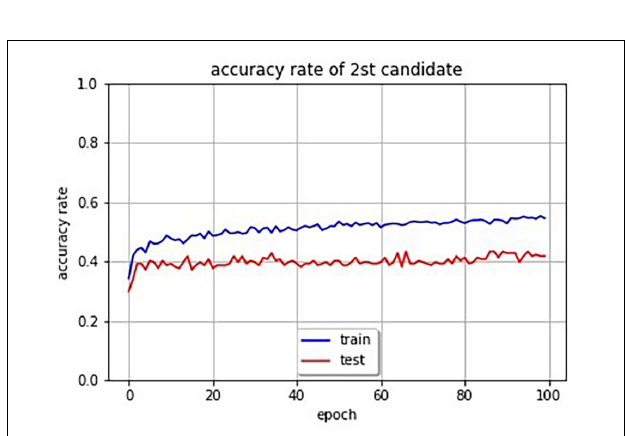
FIGURE 5 | Accuracy rate curves of second candidate SSWs (the blue line is training data and the red line is test